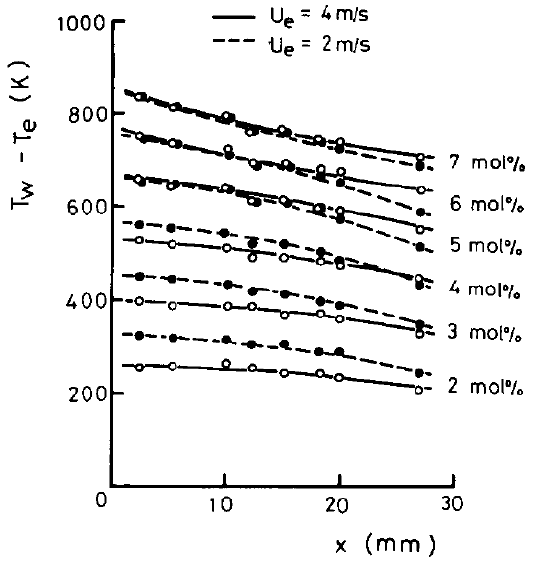
Figure 5. Surface temperature distribution of a Pt plate catalyst (reproduced from [151] with permission from Elsevier).